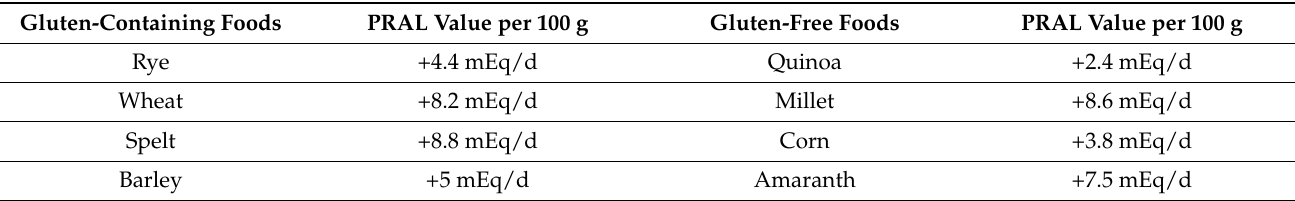
Table 1. PRAL values of selected gluten-containing and gluten-free foods: an overview. Gluten-Containing Foods PRAL Value per 100 g Gluten-Free Foods PRAL Value per 100 g Rye +4.4 mEq/d Quinoa +2.4 mEq/d Wheat +8.2 mEq/d Millet +8.6 mEq/d Spelt +8.8 mEq/d Corn +3.8 mEq/d Barley +5 mEq/d Amaranth +7.5